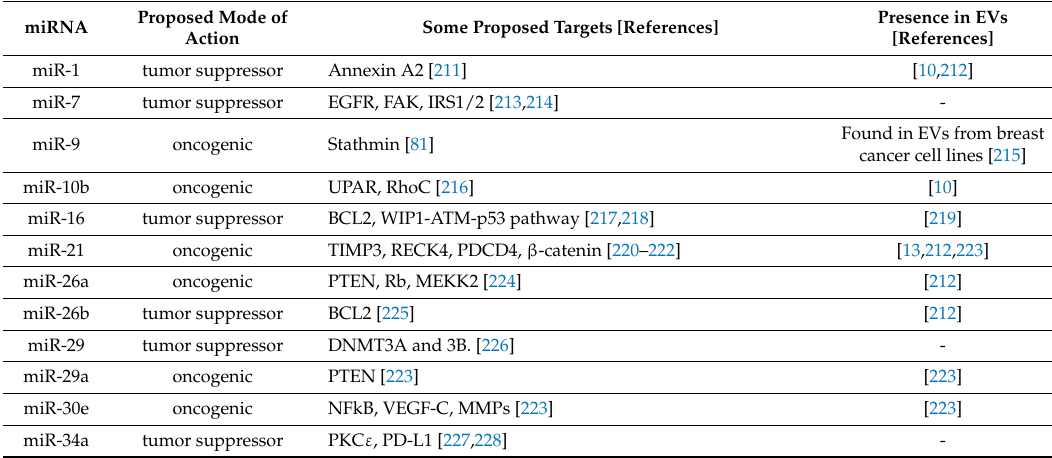
Table 2. Involvement of microRNAs (miRNAs) in glioma growth and invasion: putative mode of action of a few miRNAs, with some of their suggested targets. In the last column, when available, references in which the presence in EVs of these miRNAs has been